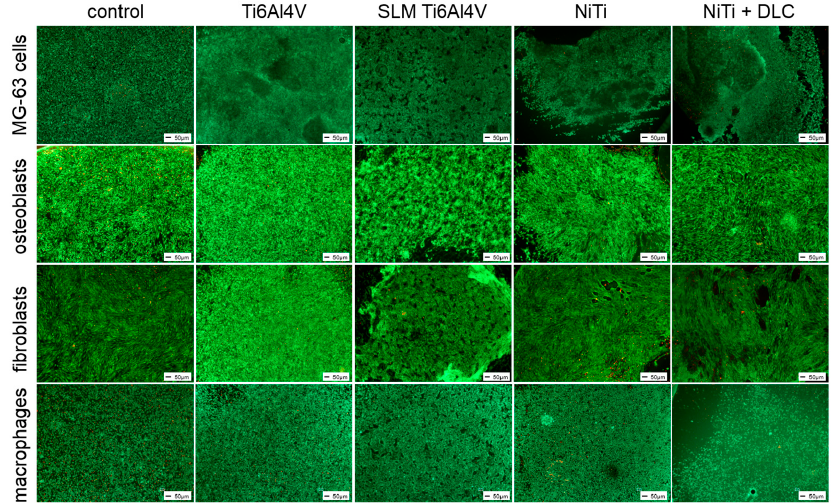
Figure 5. Live/dead staining of MG-63 cells, human osteoblasts, fibroblasts, and macrophages on different test pellets (forged Ti6Al4V, Ti6Al4V SLM, NiTi, and NiTi + DLC). Living cells are displayed in green, dead ones in red. Scale bar: 50 μ m.